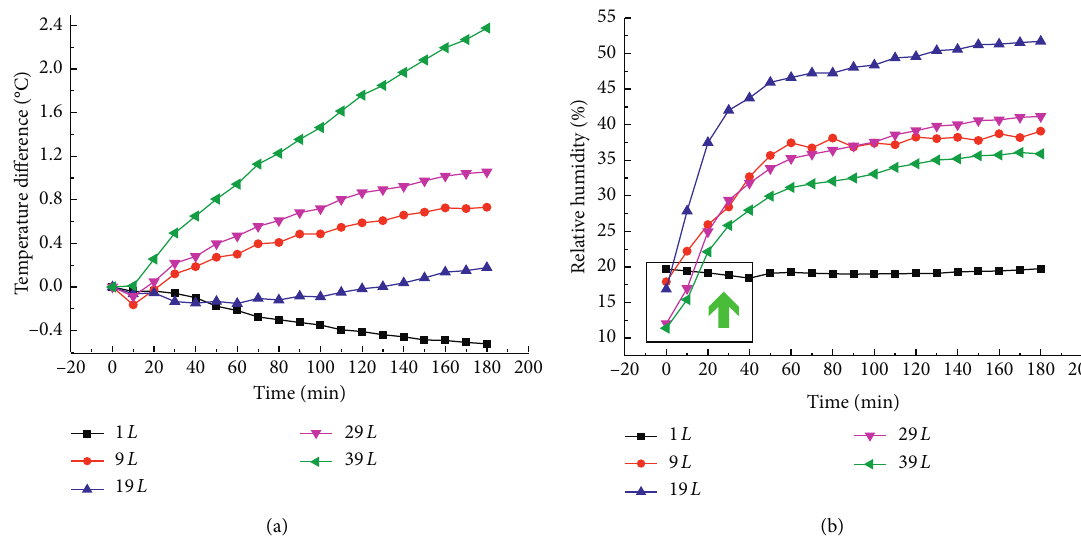
Figure 7: Temperature difference and relative humidity variations at different measuring points. (a)100ml/min–80 ° C. (b) 200ml/min–60 ° C.